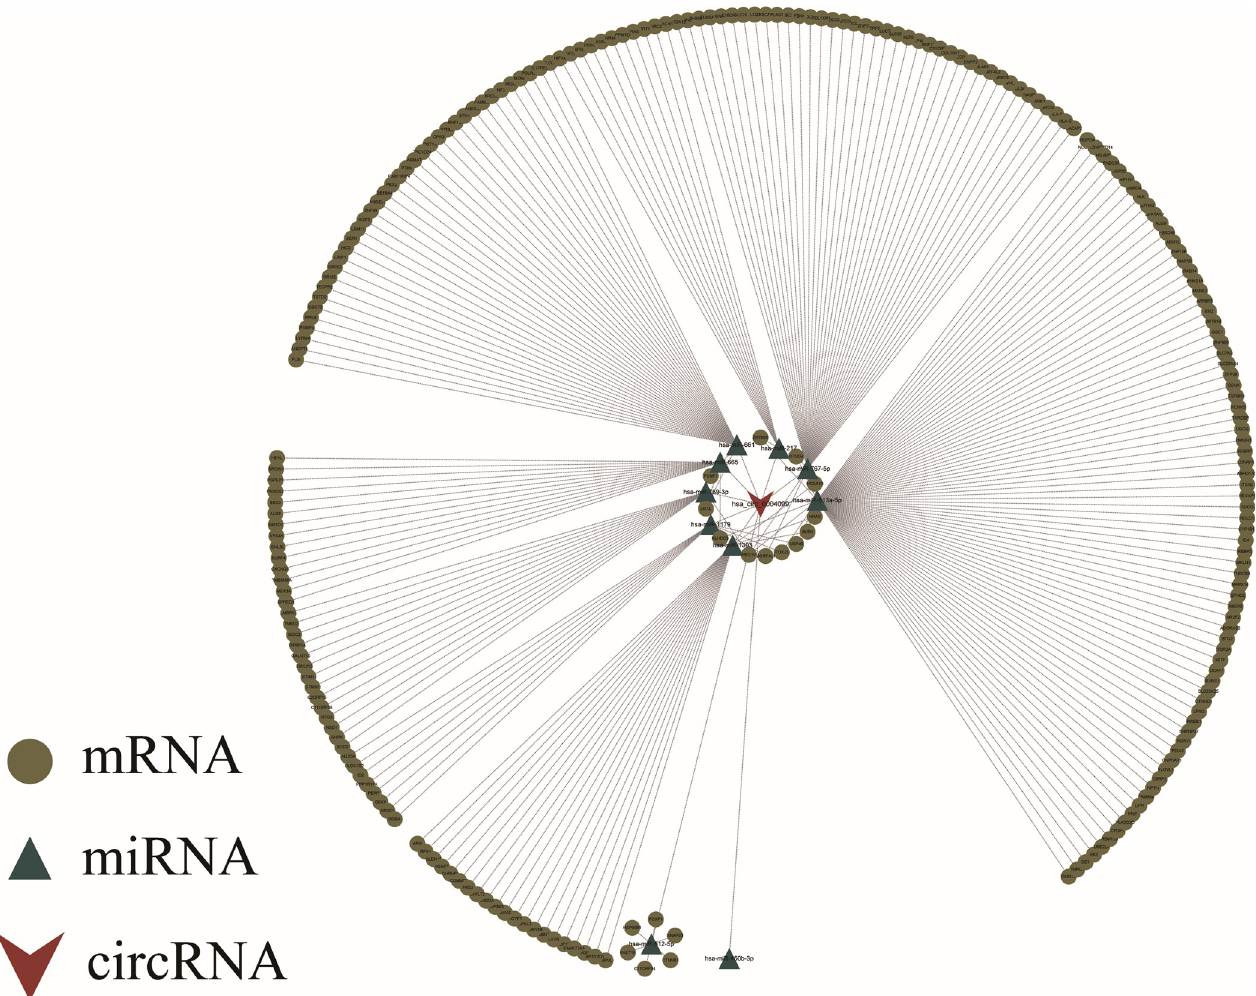
Fig 5. Circular RNA-microRNA-mRNA (circRNA-miRNA-mRNA) network. Inverted triangles represent hsa_circ_0004099, triangles represent miRNAs, while circles represent